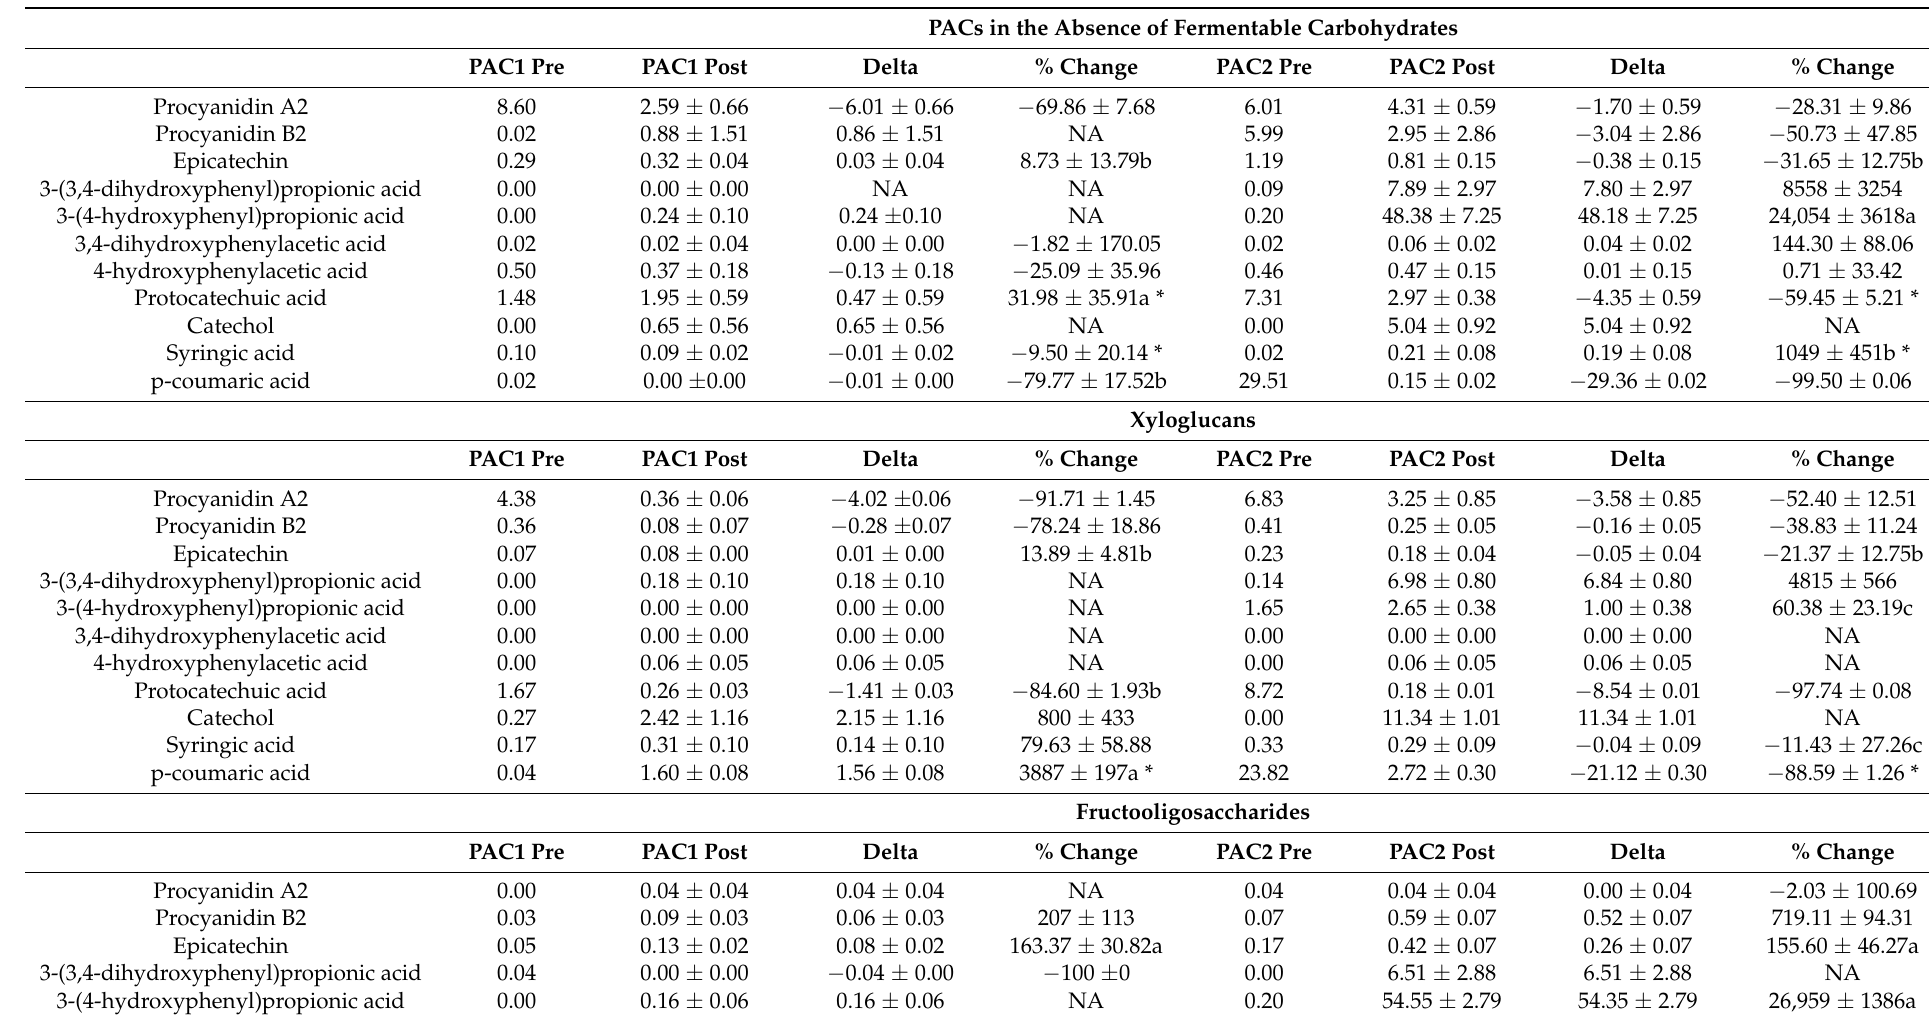
Table 1. Cranberry phenolic metabolites produced during Lactobacillus plantarum oligosaccharide fermentation